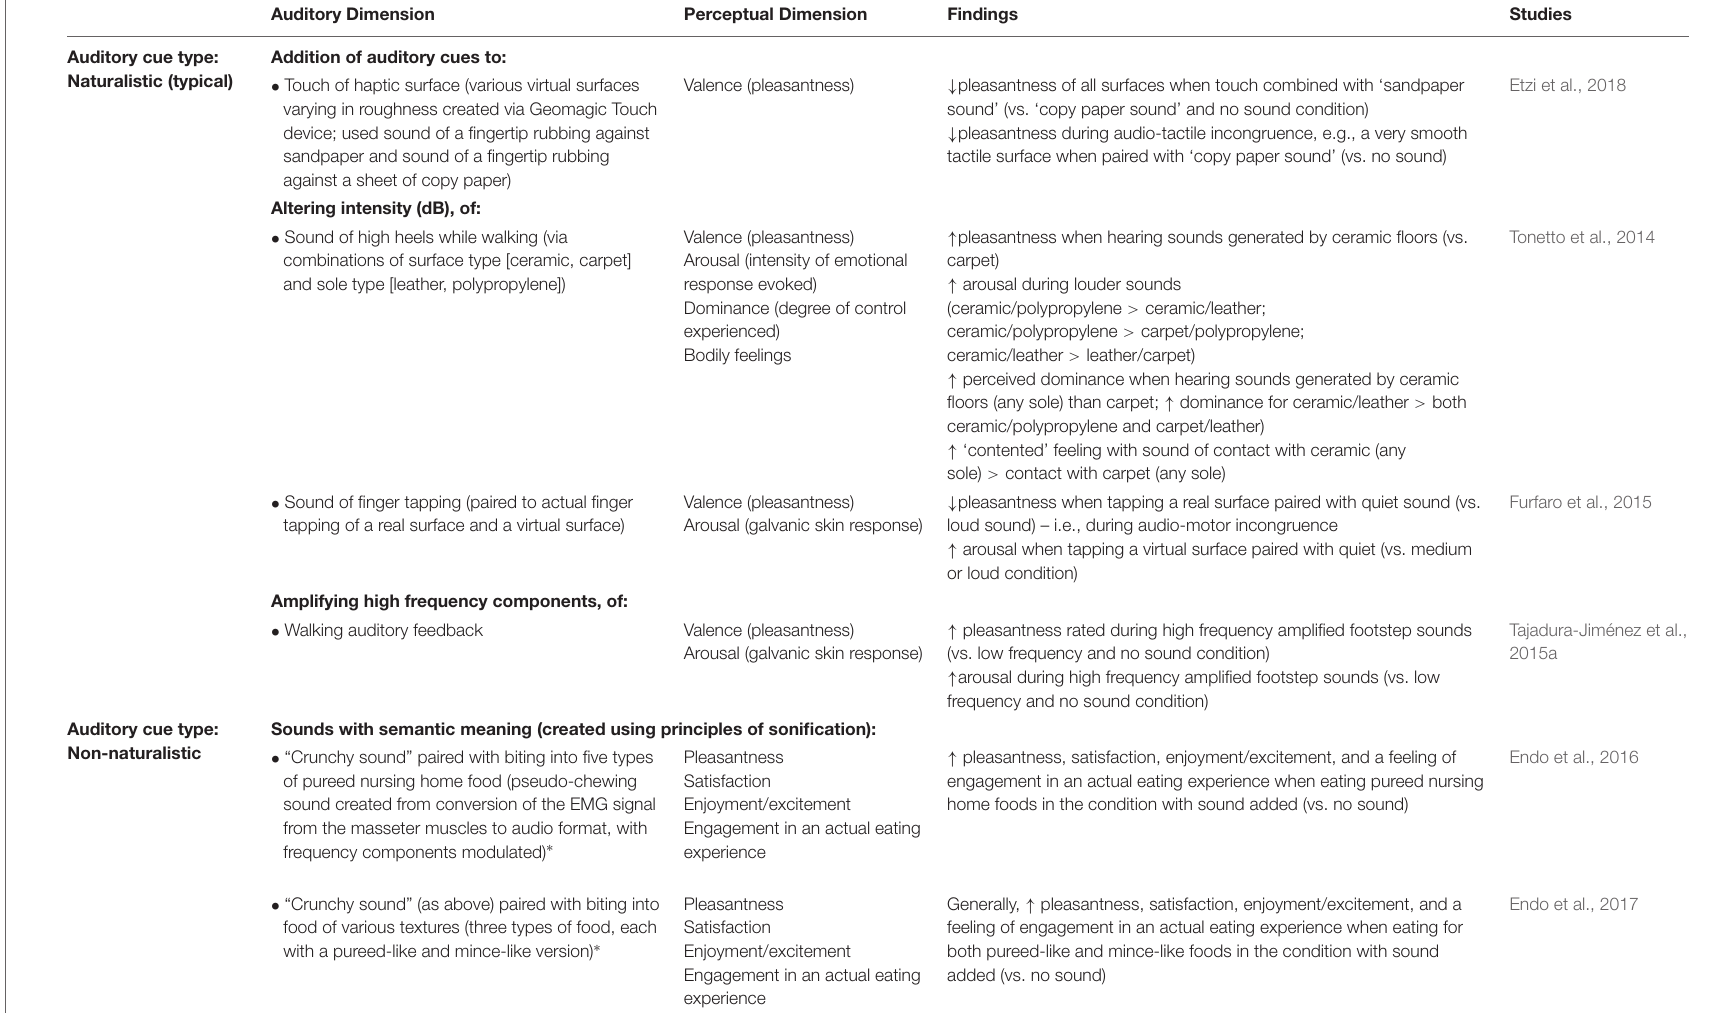
TABLE 5 | Summary of the effects of non-veridical auditory cues on emotional response and on the pleasantness of movement-related activity. Auditory Dimension Perceptual Dimension Findings